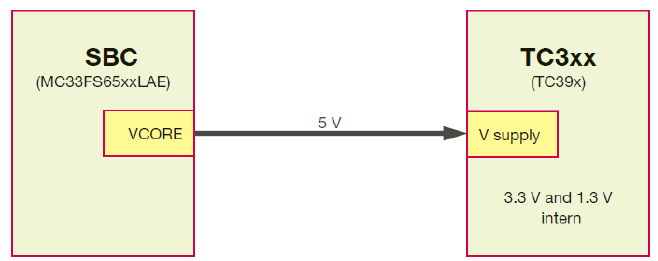
Figure 1. Supply concept overview of a unique 5 V supply generated by a system basis chip (SBC).